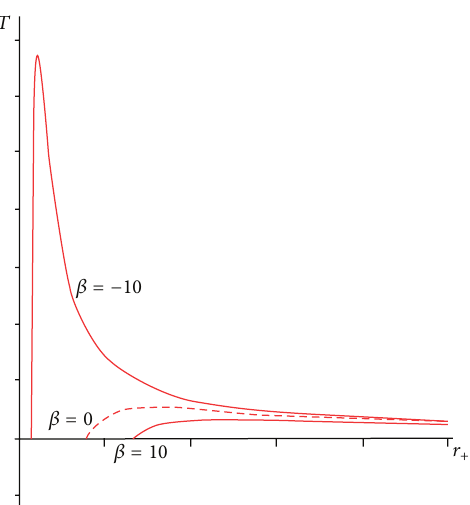
Figure 2: Characteristic behaviour of the temperature of the black hole 𝑇 as a function of the horizon radius 𝑟 + for different values of the parameter 𝛽 . In the three plots, we use 𝑞 = 1 and 𝑎 = 1.25 . The dotted line corresponds to the temperature 𝑇 Kerr-Newman solution (i.e., 𝛽 = 0